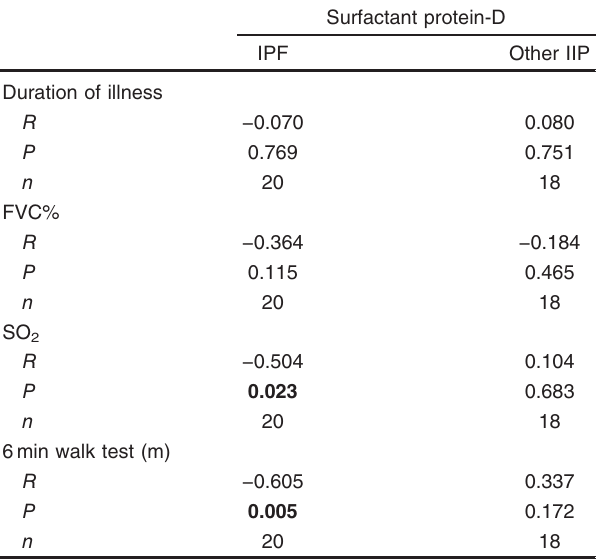
Table 7 Correlation between the serum level of surfactant protein-D with duration of illness, forced vital capacity percent, oxygen saturation, and 6min walk